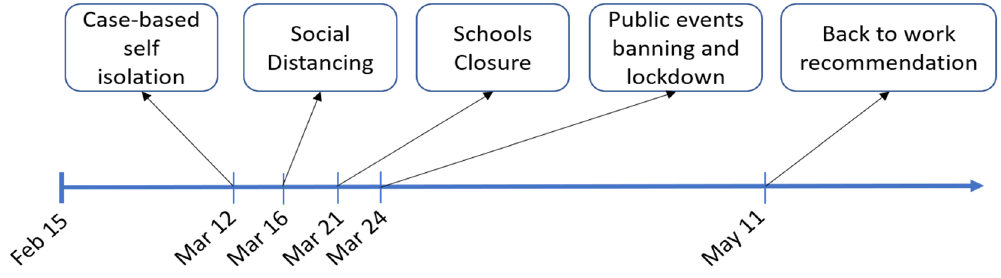
Figure 2. Non-pharmaceutical interventions applied by the UK government.